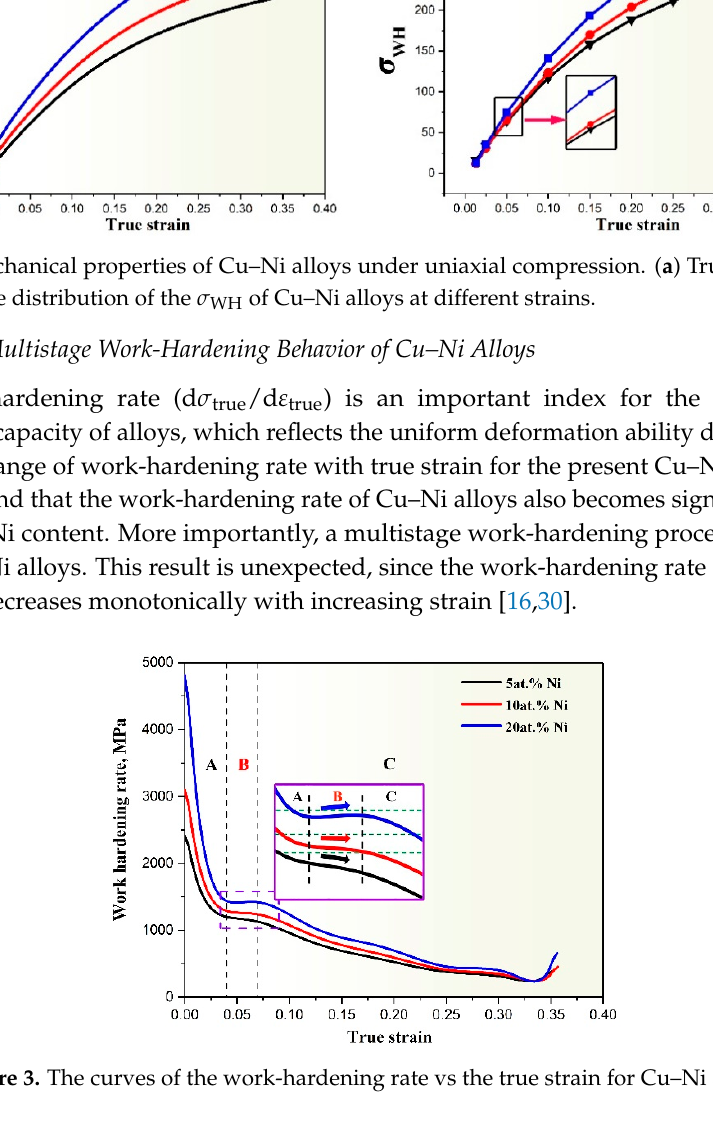
Figure 2. Mechanical properties of Cu–Ni alloys under uniaxial compression. ( a ) True stress–strain curves; ( b ) the distribution of the σ WH of Cu–Ni alloys at different strains.